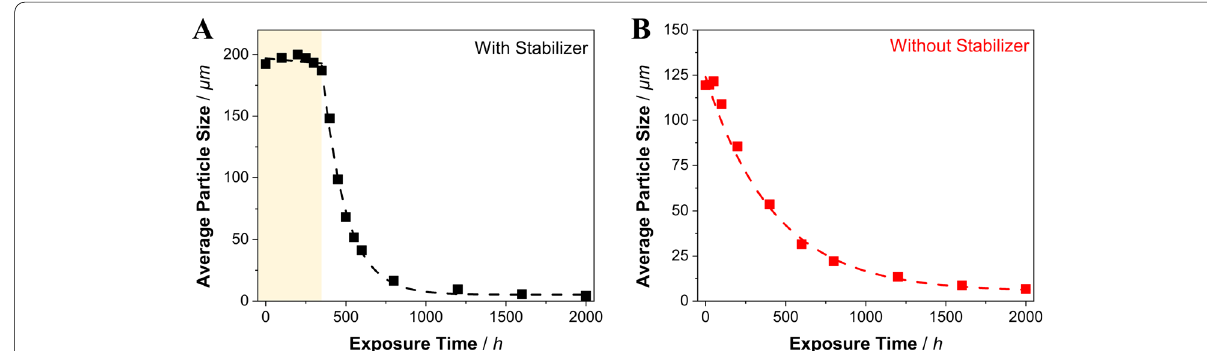
Fig. 1 Average particle size for A PP particles with stabilizer and B PP particles without stabilizer. The induction phase, characterized by the presence of Irgafos ® 168 and Irganox ® 1010, is highlighted in yellow. Degradation proceeds in an exponential manner with τ and τ 427 h for PP without stabilizer ( exp( = ∝ −